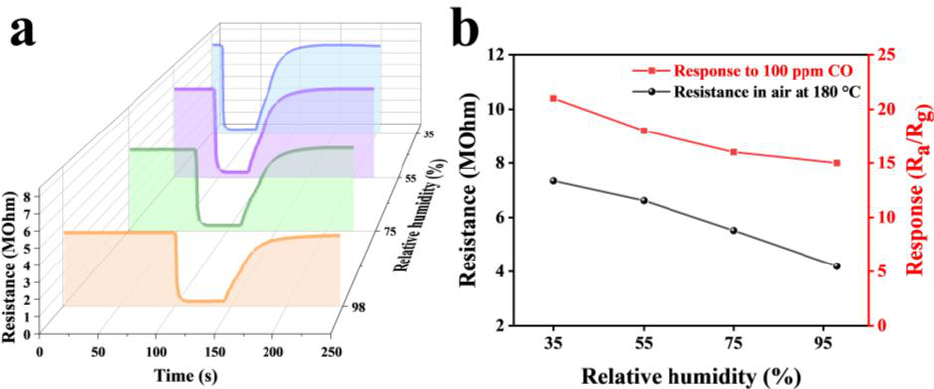
Figure 10. ( a ) The dynamic response curves and ( b ) the corresponding response and resistance relations of the sensors based on Au2Pd2-In 2 O 3 nanofibers under different humidity conditions (35%, 55%, 75%, 98%) at the operating temperature of 200 °C.